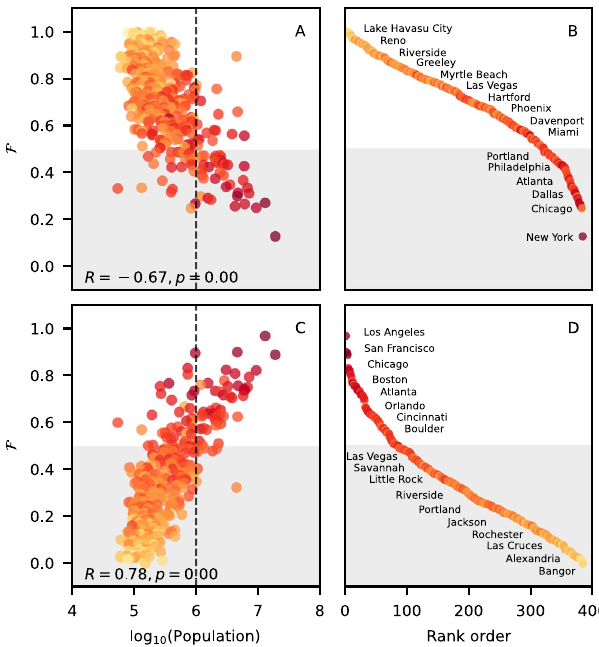
Fig. 5|Inter-city fl owpatternsdependonthepopulationsizeoftheorigin and destination cities. Each point corresponds to a particular city. A Fraction F of net fl ows going to lower density counties versus the population of the destination city. In fl ows to counties of large cities (with population greater than 10 6 , dashed line) usually comes from counties with lower population densities. B Rank of cities according to the share of in fl ows from lower density counties. C Fraction F versus thepopulationoftheorigincity.Out fl owsfromcountiesoflargecitiesusuallygoto cities with lower density counties. D The rank of cities according to the share of inter-city net fl ows to lower density counties is presented. The dots are colored accordingtothecitypopulationdensity(darkerredmeanshigherdensity).Wealso showthePearsoncorrelationcoef fi cient R andthe p -valueassociatedwiththetwo- sided test of the null hypothesis of